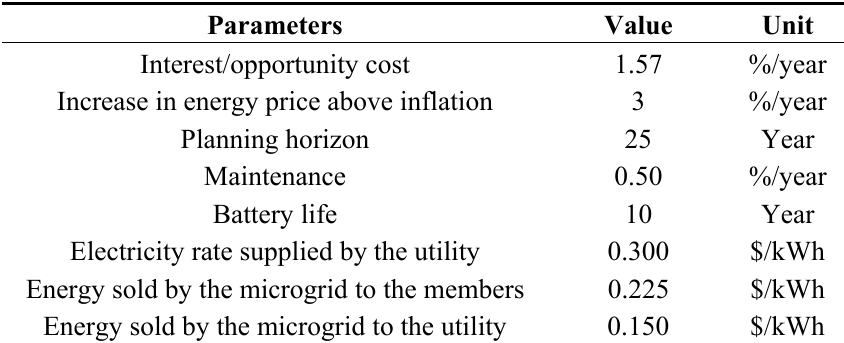
Table 1. Parameters for economic